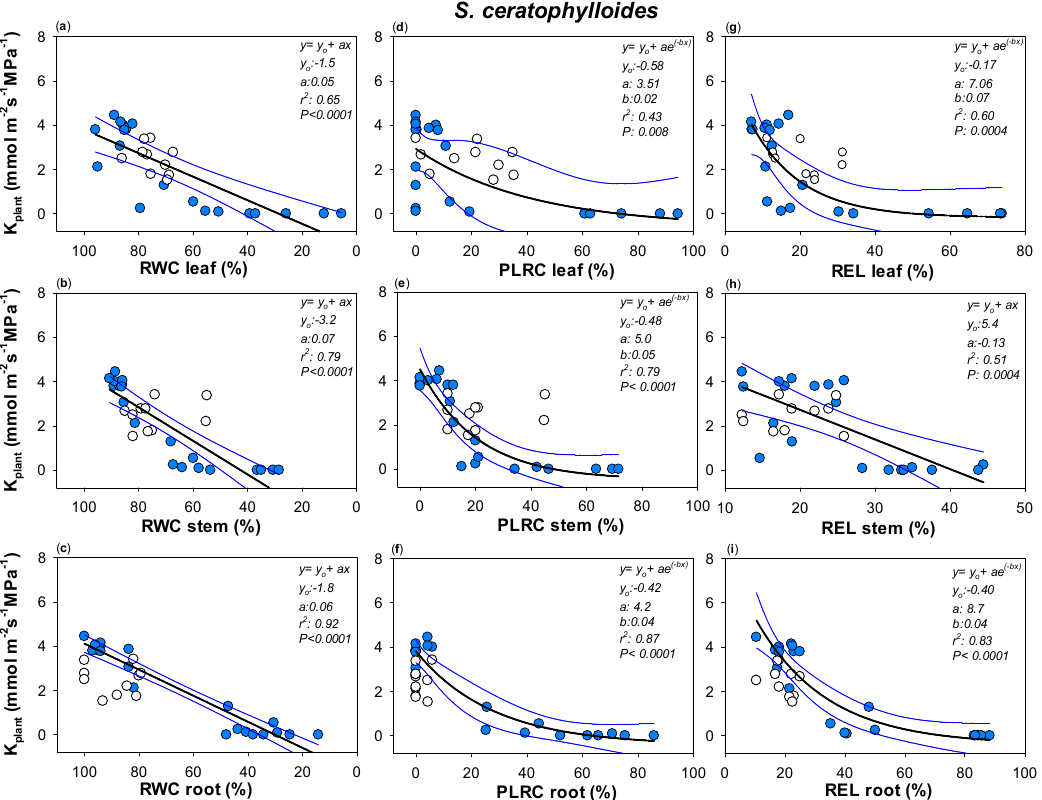
Figure 4. Relationships between plant hydraulic conductance (K plant ) and ( a ) leaf, ( b ) stem and ( c ) root relative water content (RWC leaf, RWC stem and RWC root, respectively), ( d ) leaf, ( e ) stem and ( f ) root percentage loss of leaf rehydration capacity (PLRC leaf, PLRC stem, PLRC root) and ( g ) leaf, ( h ) stem and ( i ) root relative electrolyte leakage (REL leaf, REL stem and REL root) as measured in S. ceratophylloides . Best fitted regression curves are designed by dark line. Confidence intervals are designed by blue lines. White symbols indicate data recorded in re-irrigated samples and not included in the regression. Regression equation, coefficient values, correlation coefficients (r 2 ) and p values are also reported.